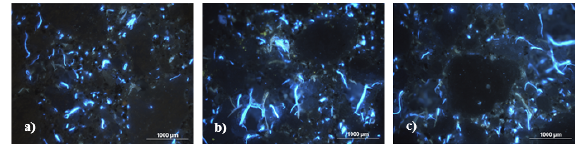
Figure 2: Photomicrographs of 28 days hardened fibre cement com- posite texture in the UV light with WU filter a) G-500T 0.5% b) G- 700T 0.5% c) G-3/00T 0.5%